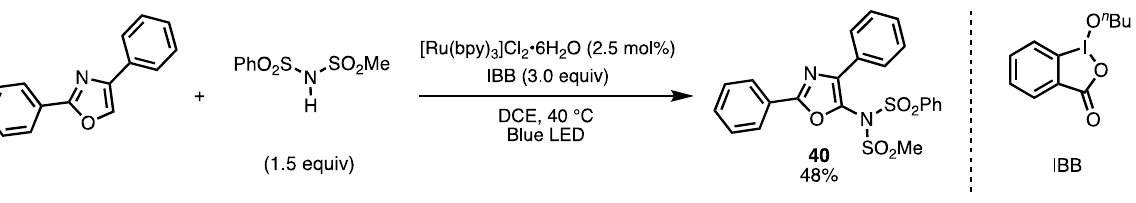
Procedure for the synthesis of SIM1 derivatives through photoredox‑catalyzed C–H imidation 36 .